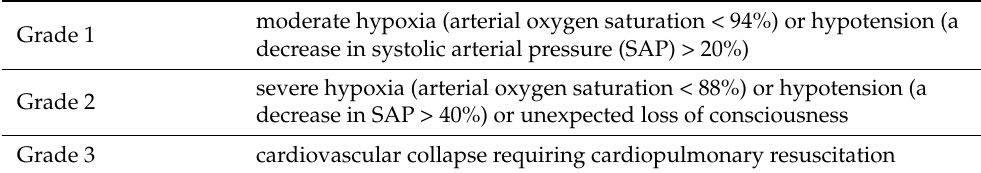
Table 1. Classification Bone Cement Implantation